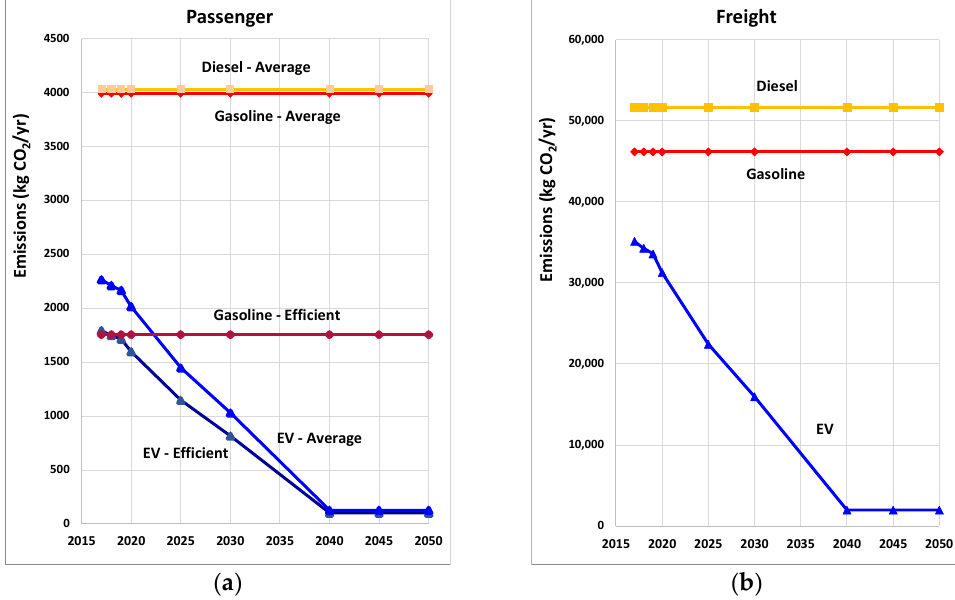
Figure 8. Annual CO 2 emissions for vehicles on Oahu from 2017 through 2020 and projected to 2050 under the faster renewable power projection: ( a ) Passenger; ( b ) Freight.